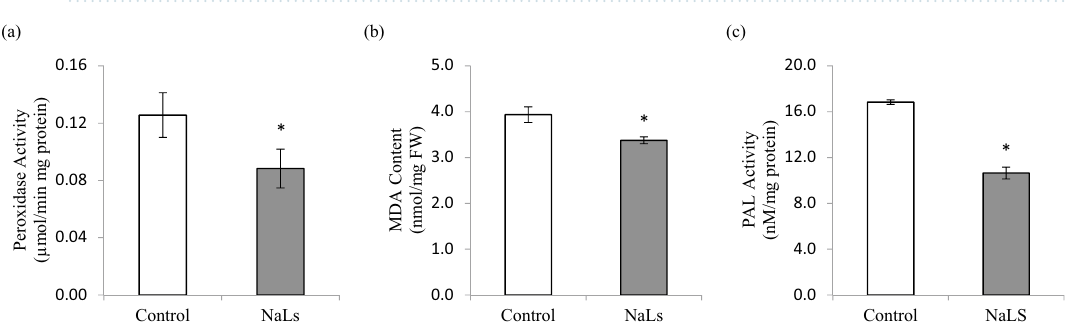
Figure 3. Evaluation of photosynthetic activity and protein biosynthesis related assays on MSO and NaLS- treated rice after 3 weeks incubation. ( a ) Total chlorophyll content; ( b ) rubisco activity; ( c ) total sugar content and ( d ) total protein content. Results show the mean of three biological replicates with error bars represent standard deviation. Asterisk indicates statistically significant difference at p < 0.05 when compared with MSO.